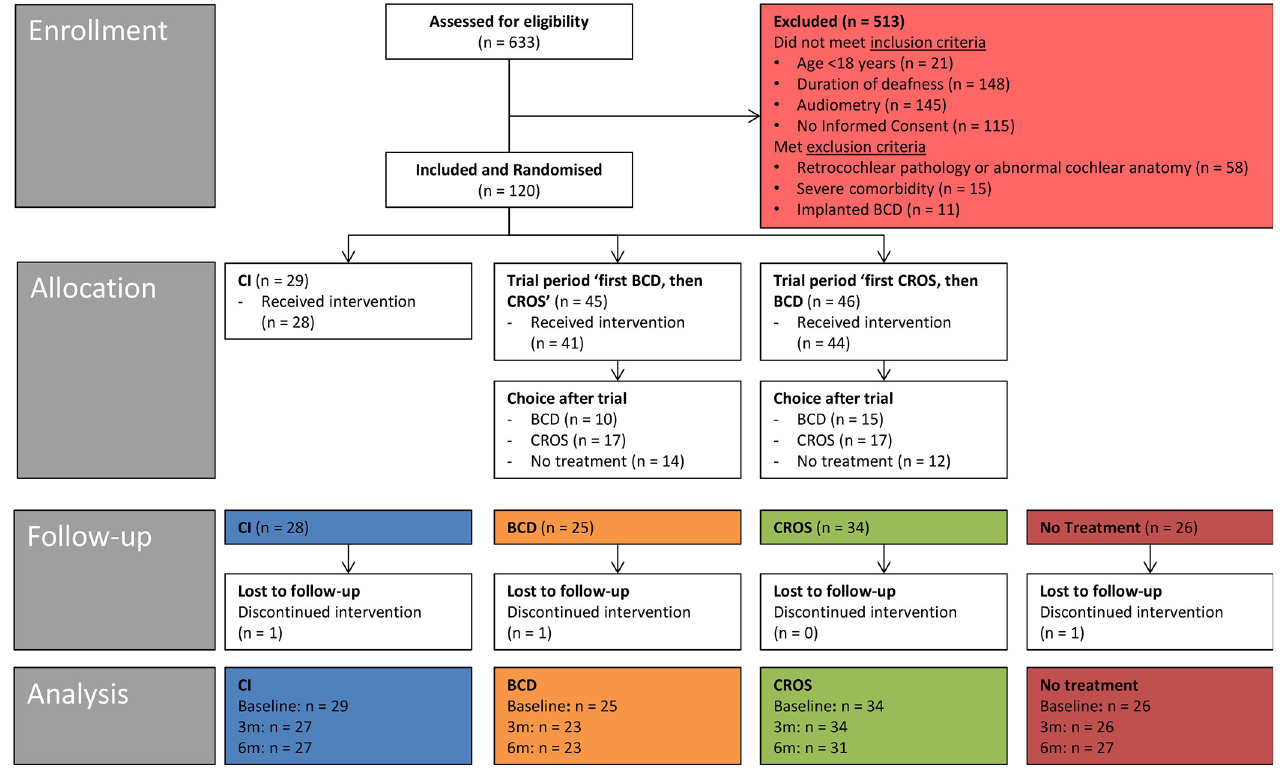
Fig 1. CONSORT flow diagram of the study. See S3 File for an explanation of the numbers per group at different moments.